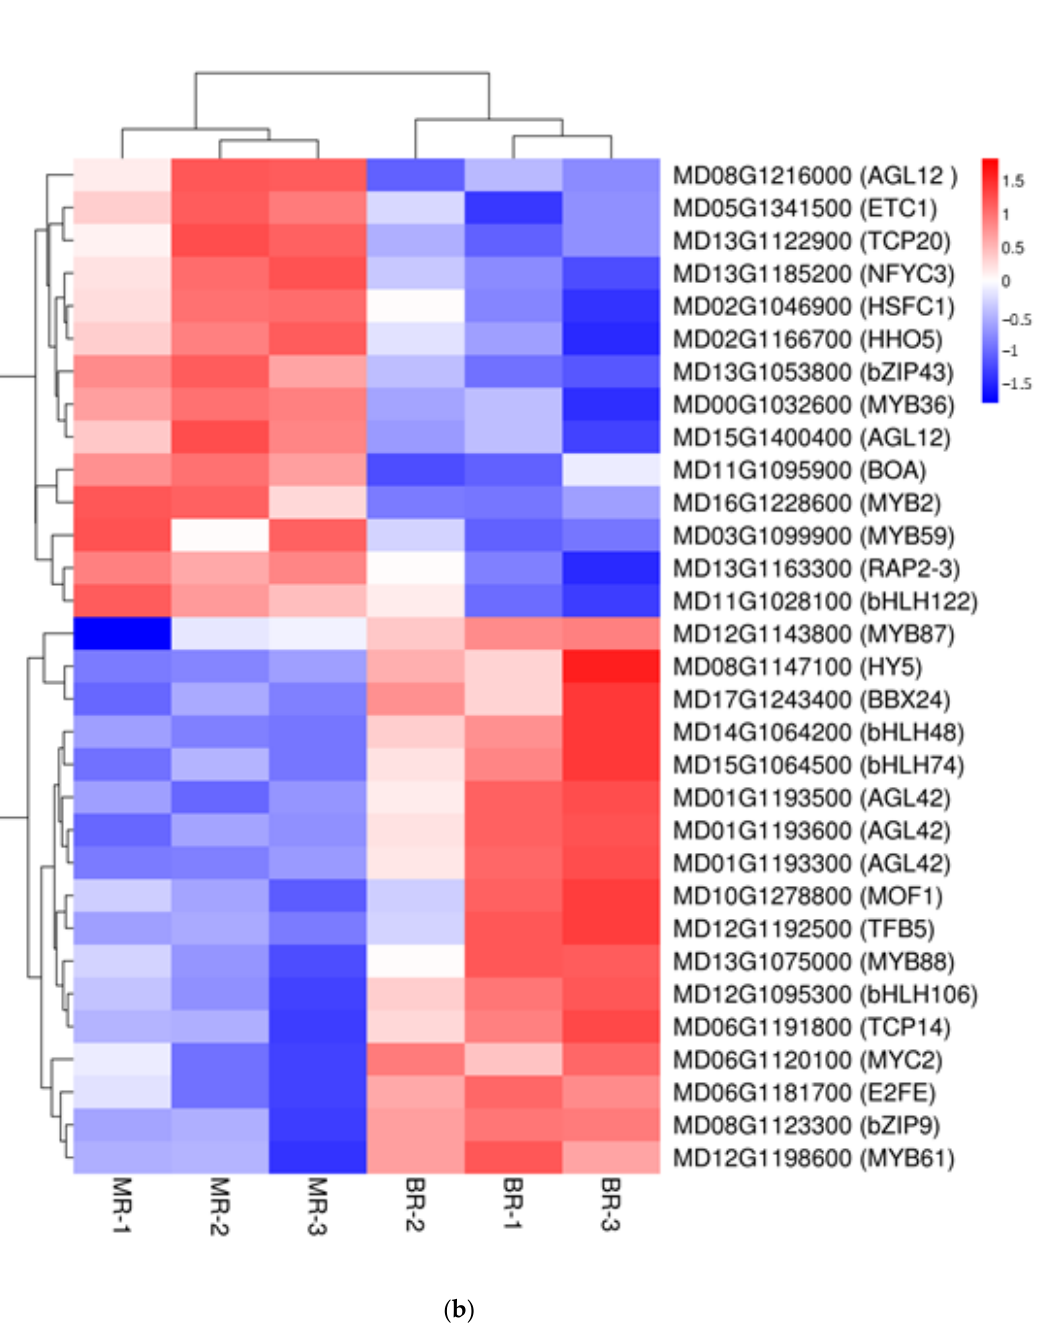
Figure 7. Heat map of differentially expressed transcription factors with grafted interstocks. ( a ) Differentially expressed transcription factors of BS vs. MS. ( b ) Differentially expressed transcription factors of BR vs. MR ( heat map color indicates normalization of FPKM values).